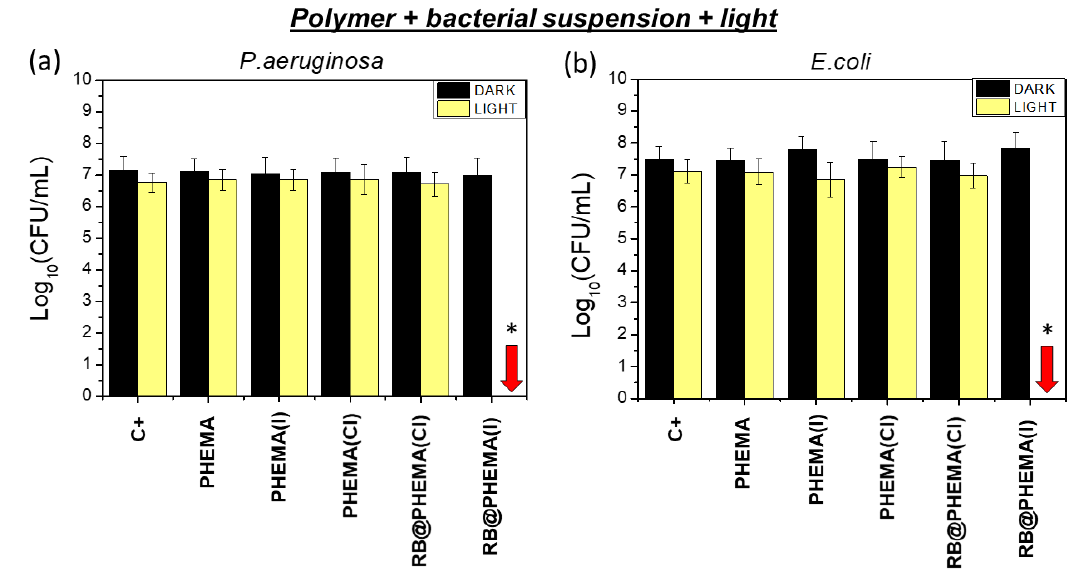
Figure 5. Photodynamic Inactivation Assays (5 min irradiation, 24 J/cm 2 ) against P. aeruginosa ATCC 27853 ( a ) and E. coli CECT 101 ( b ) Using Polymer PHEMA Materials. Bacterial cell survival was evaluated by counting colony-forming units (CFU) on MHA at 35 °C for 24 h. The results are expressed as mean ± standard deviation. Asterisk (*) indicates significant differences ( p < 0.01). Red arrow indicates complete eradication.